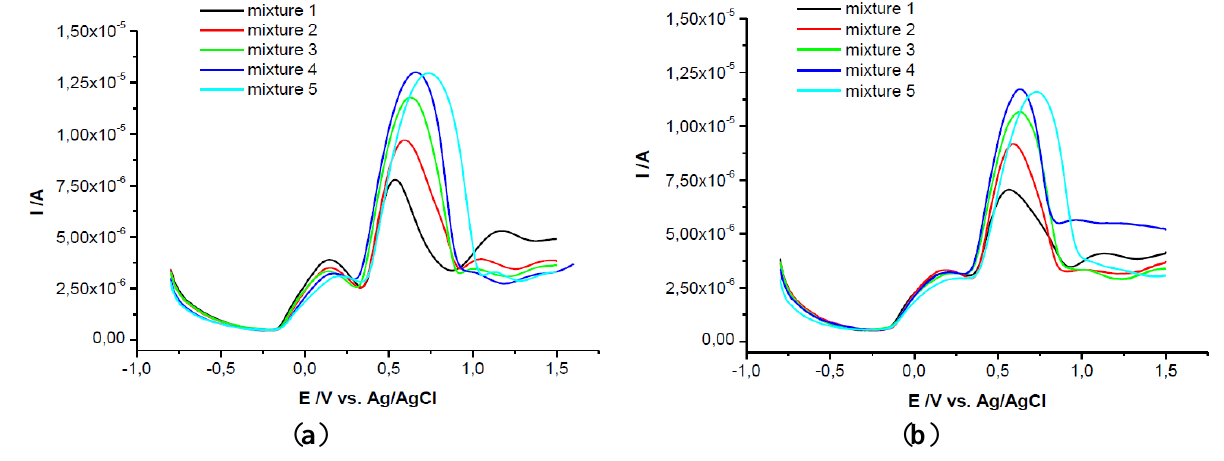
Figure 6. SWVs of the five mixtures on GCE/PEI (5 mg/mL) + β-CD (1%) ( a ) and on GCE/PEI (1 mg/mL) + β-CD (0.2%) ( b ) (mixture 1) 10 −3 M both substances, (mixture 2) 2 × 10 −3 M UA, (mixture 3) 4 × 10 −3 M UA, (mixture 4) 6 × 10 −3 M UA, (mixture 5) 8 × 10 −3 M UA, all mixtures contained 10 −3 M AA; ( c ) calibration curve for (a); ( d ) calibration curve for